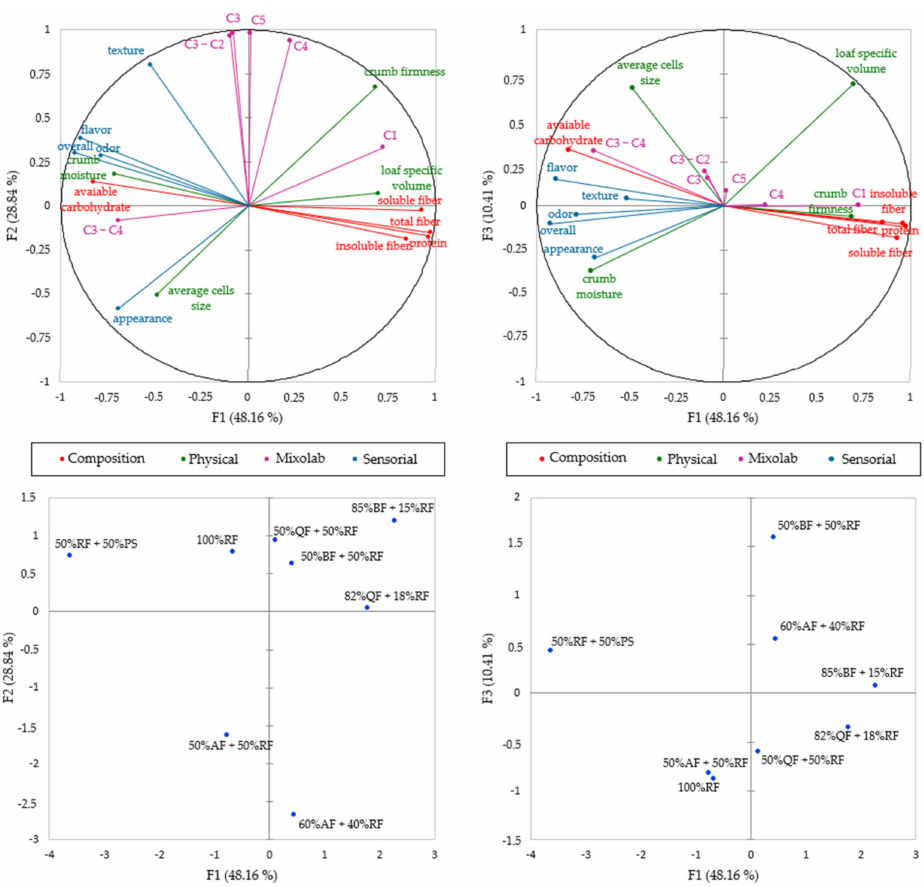
Figure 5. Multiple factor analysis correlating the physical (in green), sensorial (in blue), proximate composition (in red) and Mixolab parameters (in purple) of the selected gluten-free bread formula- tions. Bread ID: rice flour (RF), potato starch (PS) and pseudocereal flours: amaranth (AF), buckwheat (BF) and quinoa